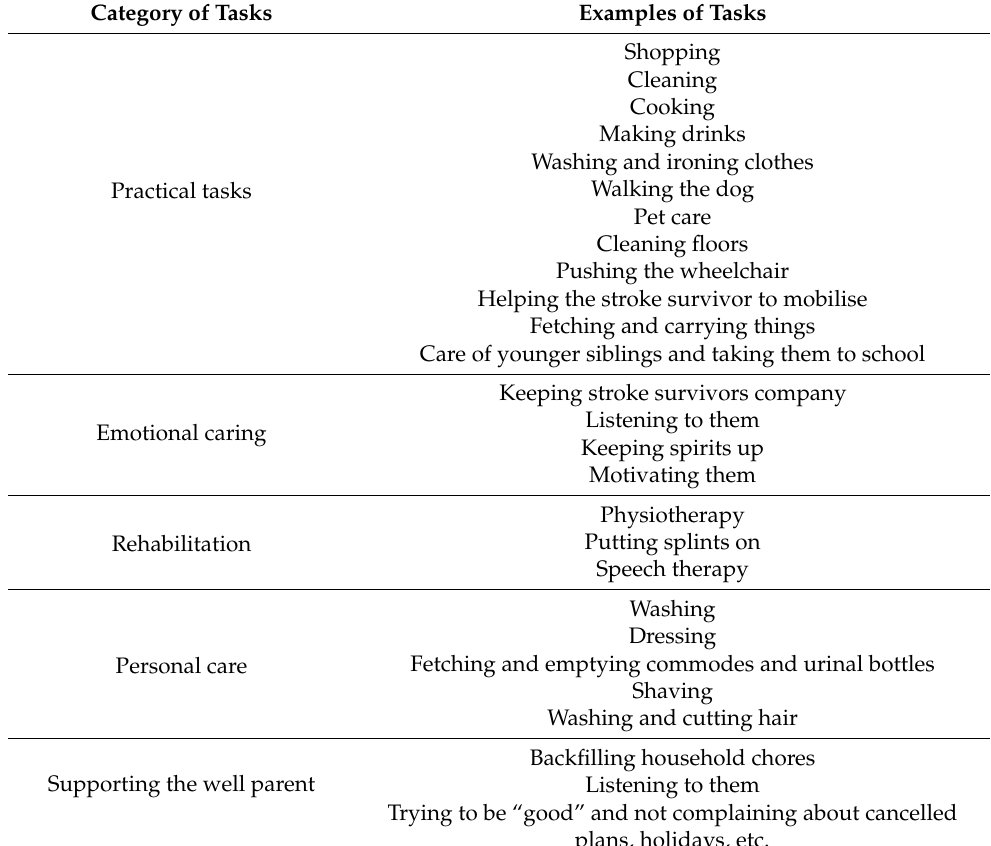
Table 5. Tasks of caring. Category of